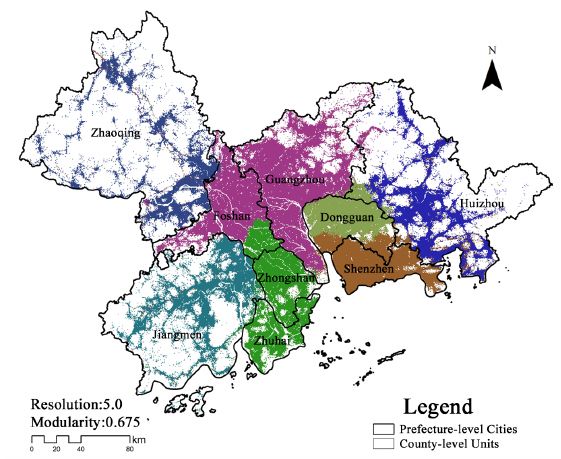
Figure 6 . The backbone network in the PRD ( α =4*10 -3 ).